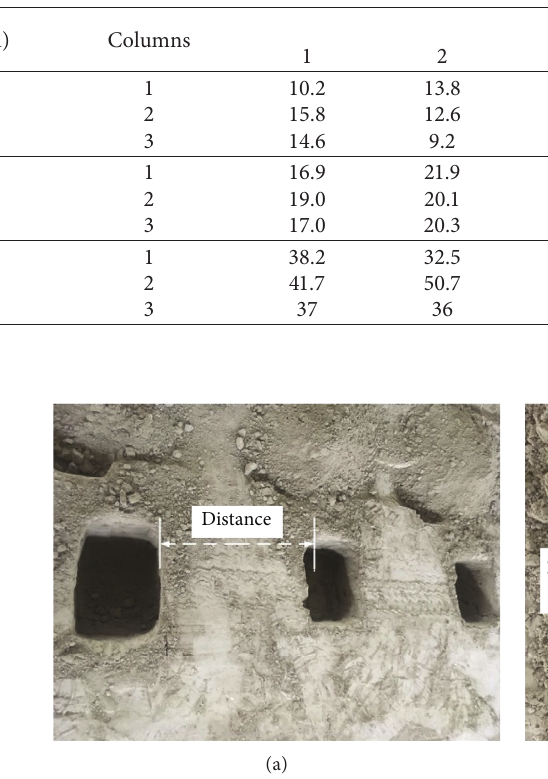
Figure 1: Test system. (1) Wheel assembly, (2) single wheel frame, (3) connection bearing, (4) computer, (5) acceleration sensor, (6) tractor, (7) signal amplifier, (8) data acquisition instrument, and (9) fixing device. Table 1: Test statistics of solidarity (unit: kg/cm 2 ).